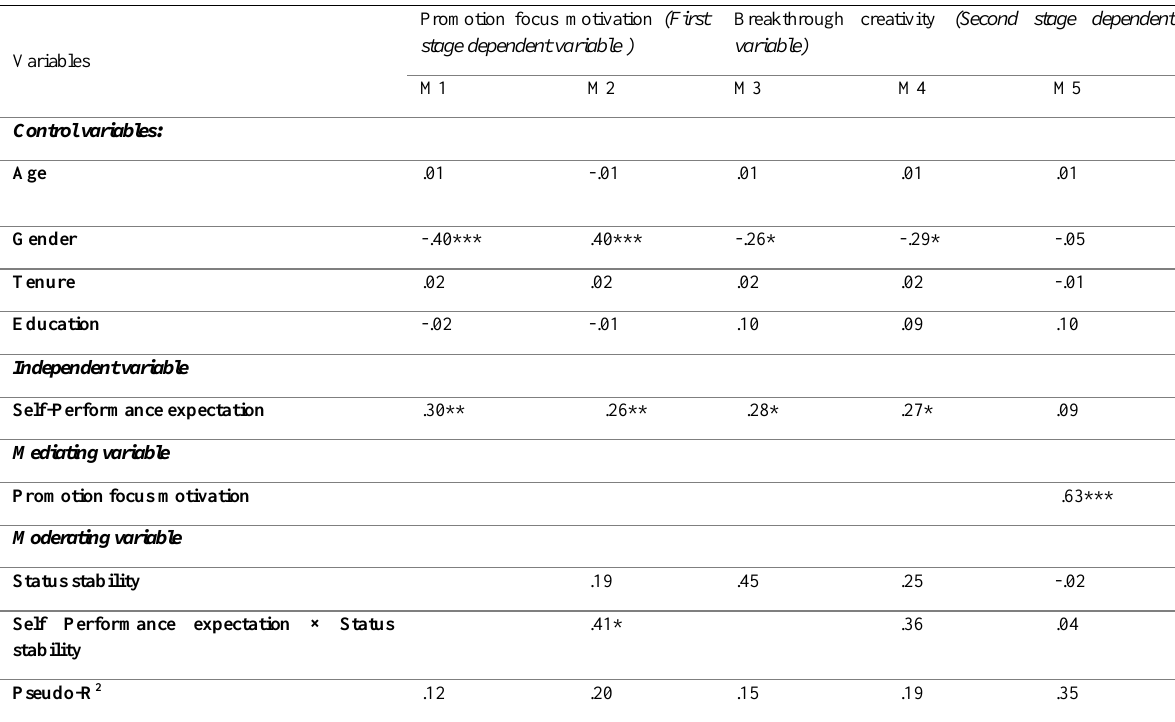
Table 4: Results of hierarchical linear modeling